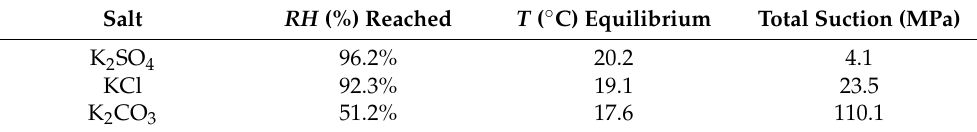
Table 4. Salts used to determine the total suction by the equilibrium vapor